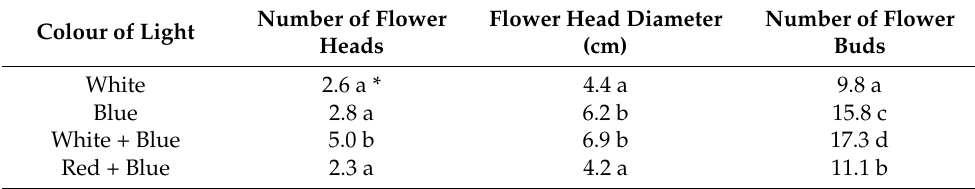
Table 3. The effect of light colour on generative feature of chrysanthemum. Number of Flower Flower Head Diameter Colour of Light Heads